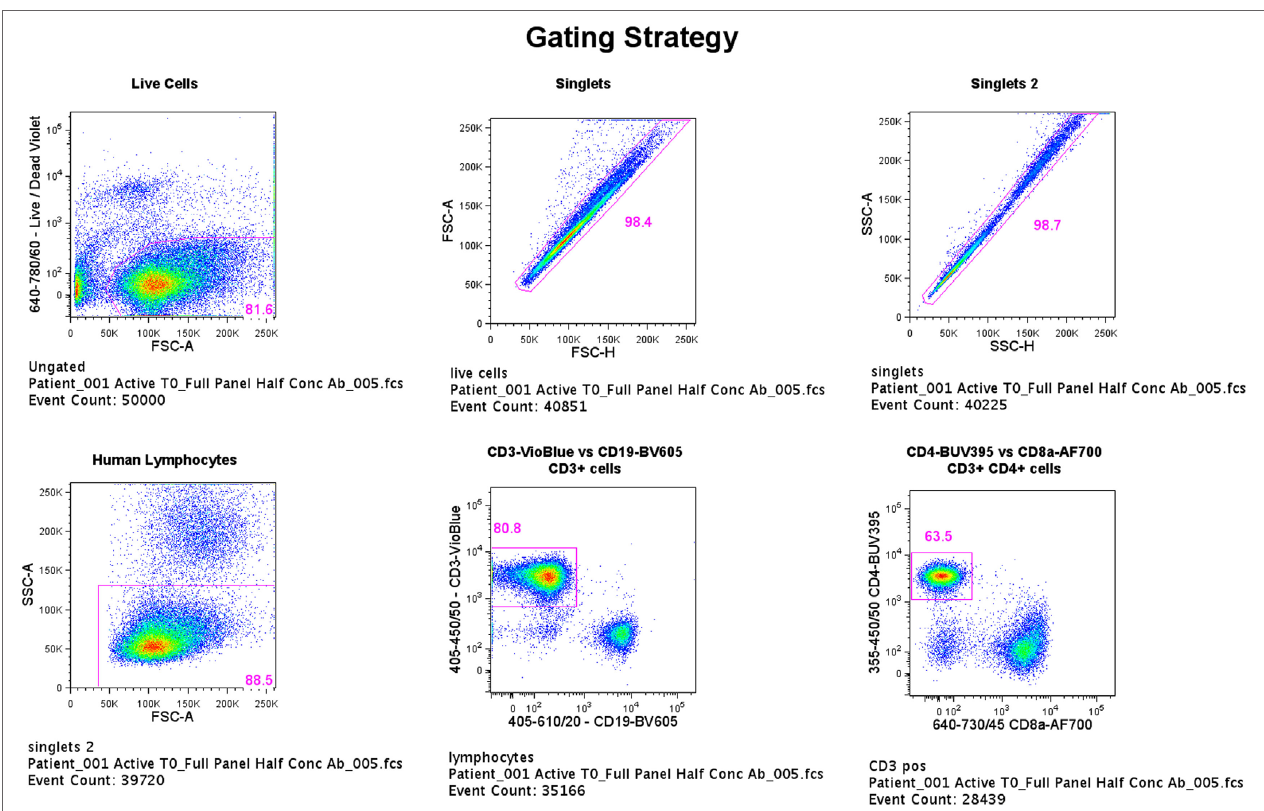
FigUre 1 | Flow cytometry gating strategy. Flow cytometric data were acquired using an LSRFortessa (BD Biosciences, San Jose, CA, USA) and BD FACSDiva version 6.1.3 software with a total of 50,000 events being recorded for each sample through a live, single-cell CD3 + CD4 + gate. Viable cells were identified by low uptake of the fixable dead cell stain. Single-stained OneComp and UltraComp beads (eBiosciences) were used to generate compensation matrices. Fluorescence- minus-one controls were used to identify gating boundaries where cell populations were ill